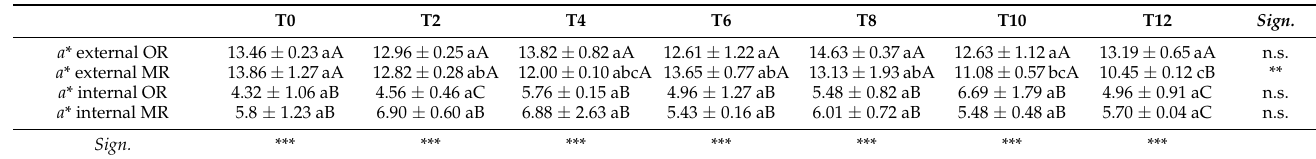
Table 2. Colours and a * values of Cantuccini biscuits made using the original recipe (OR; 50% cow’s butter/50% margarine) and modified recipe (MR; 70% EVOO/30% cow’s butter). One-way ANOVA, means ± SD (of six replicates) in the same row followed by a different letter are significantly different according to Tukey’s test; *** p < 0.001. Means in the same column are distinguished by capital letters. Means in the same line are distinguished by small